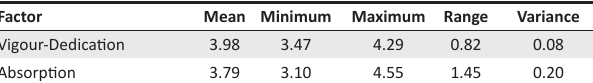
TABLE 3: Descriptive statistics of the two dimensions of work engagement.